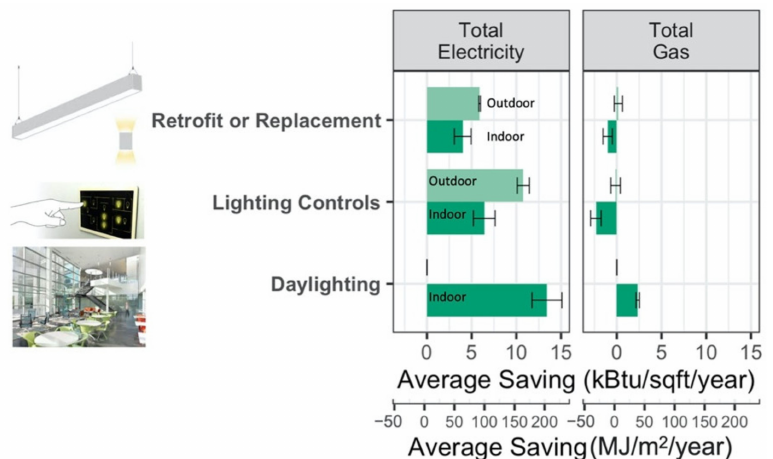
Figure 10. Bar chart of the mean and 95% C.I. of the estimated retrofit effects of past lighting retrofit